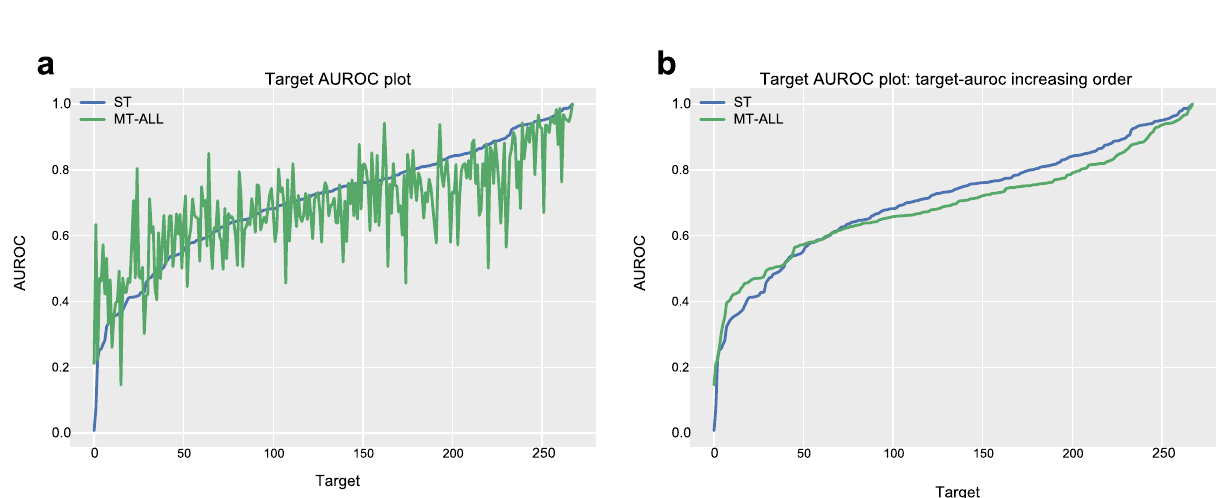
Figure 1. AUROC plot for a single-task learning model and multitask learning model. The blue line is a plot for the single-task learning model (ST), and the green line is for the multi-task learning model (MT-ALL; multi-task learning on entire targets). ( a) The target order is the same in the two plots. ( b) The target order of the two plots differs. The targets are ordered in target-AUROC increasing